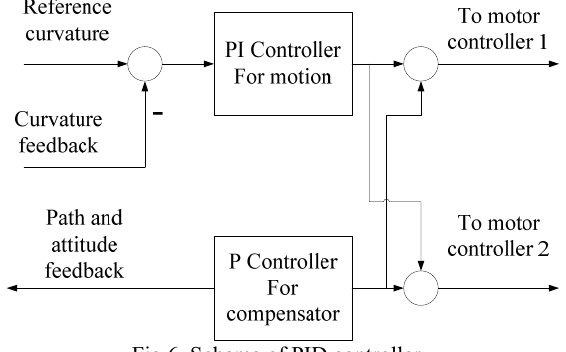
Fig.6. Schema of PID controller